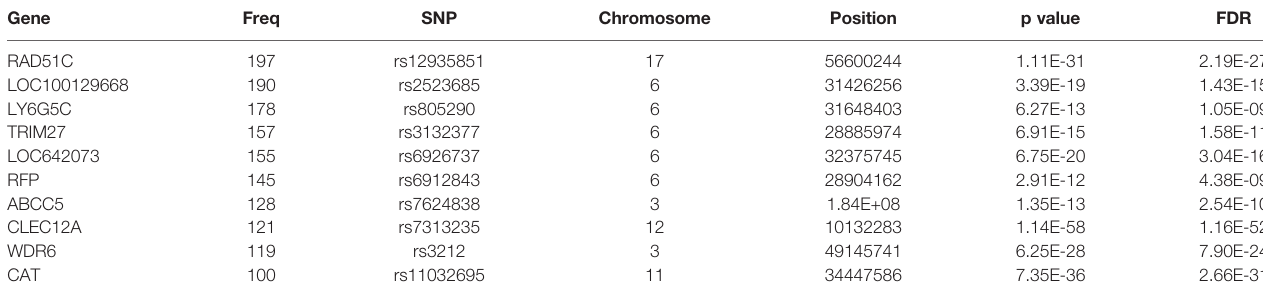
TABLE 3 | The top 10 genes with the most number of m 6 A-cis-eQTLs in